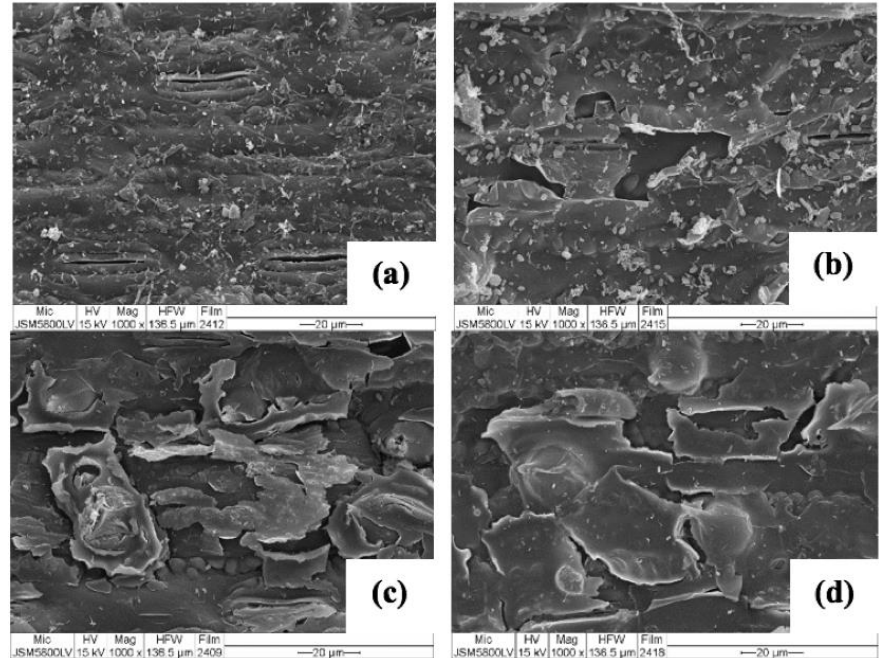
Figure 5. Napier grass silage (large size) with different sonication intensity ( a ) non-pretreated, ( b ) 556 kJ/kg TS (5 s), ( c ) 1111 kJ/kg TS (10 s), and ( d ) 1667 kJ/kg TS (15 s).